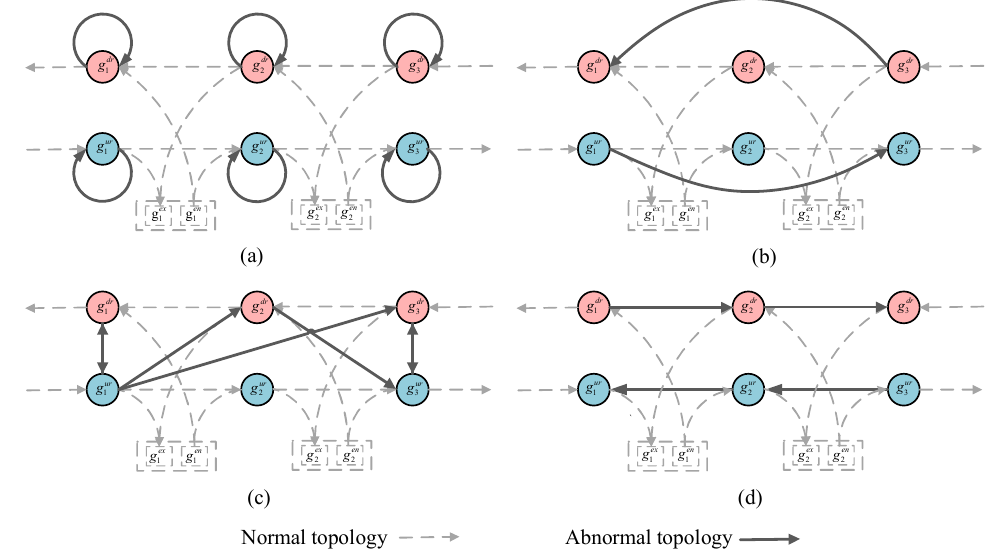
Figure 4. Schematic diagram of the abnormal topology. ( a ) loop topology; ( b ) missing topology; ( c ) opposite topology; ( d ) reverse topology.